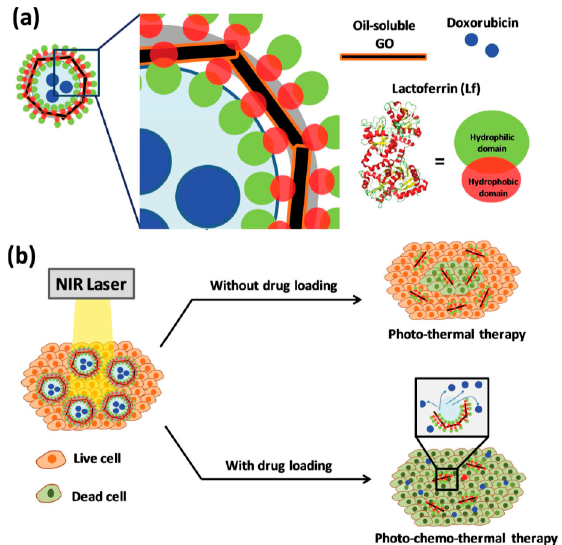
Figure 9. Schematic illustration of ( a ) core-shell protein-graphene-protein (PGP) capsules encapsulating hydrophilic doxorubicin; and ( b ) the mechanism of cancer therapy of PGP capsules under near-infrared irradiation (NIR). Reproduced with permission from [85], Copyright Wiley-VCH, 2014.